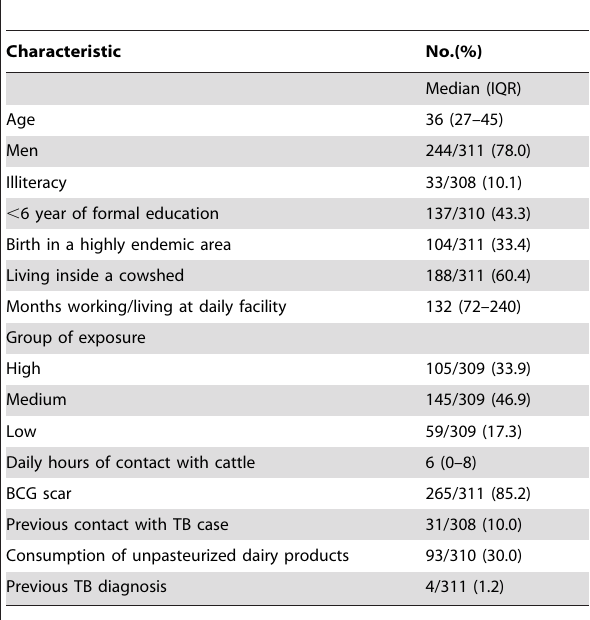
Table 3. Demographic and occupational characteristics of a study population (n= 311) linked to a dairy production and livestock facility in Mexico.